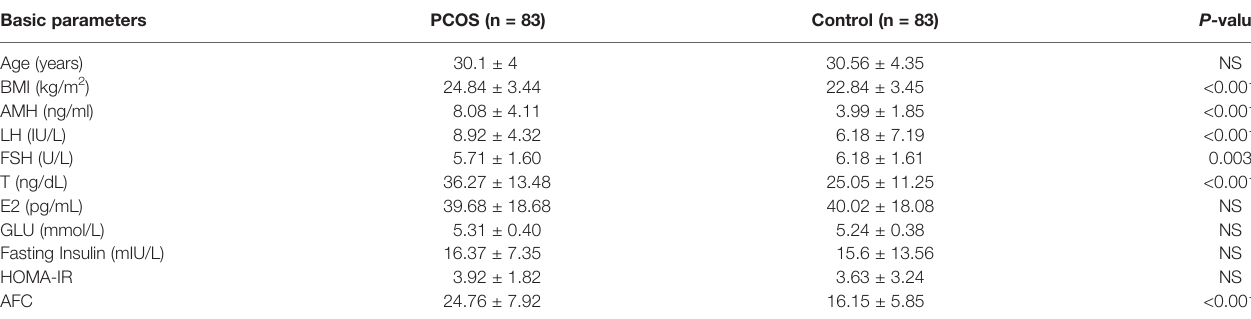
TABLE 2 | Clinical and endocrine parameters of patients with PCOS and controls. Basic